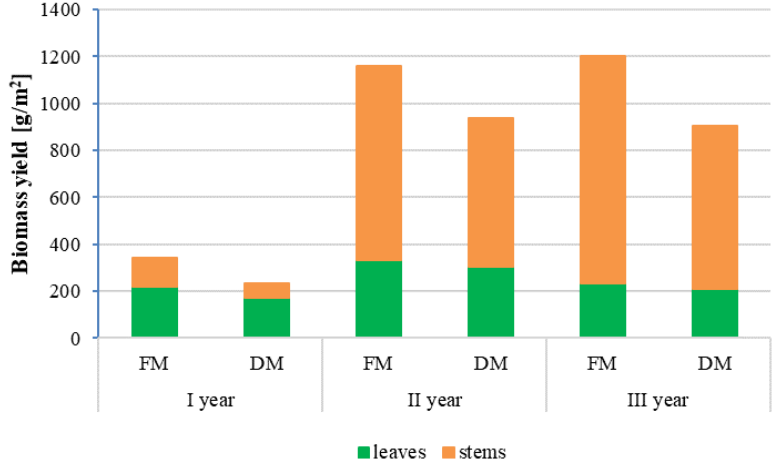
Figure 1. Share of stems and leaves in the mass of a giant miscanthus. Miscanthus biomass yield determined during the third year of vegetation (July) was 3470 g FM/m 2 , with a moisture content of 80.4%. Calculated per field unit, it yielded 34.70 Mg FM/ha and 6.80 Mg DM/ha.